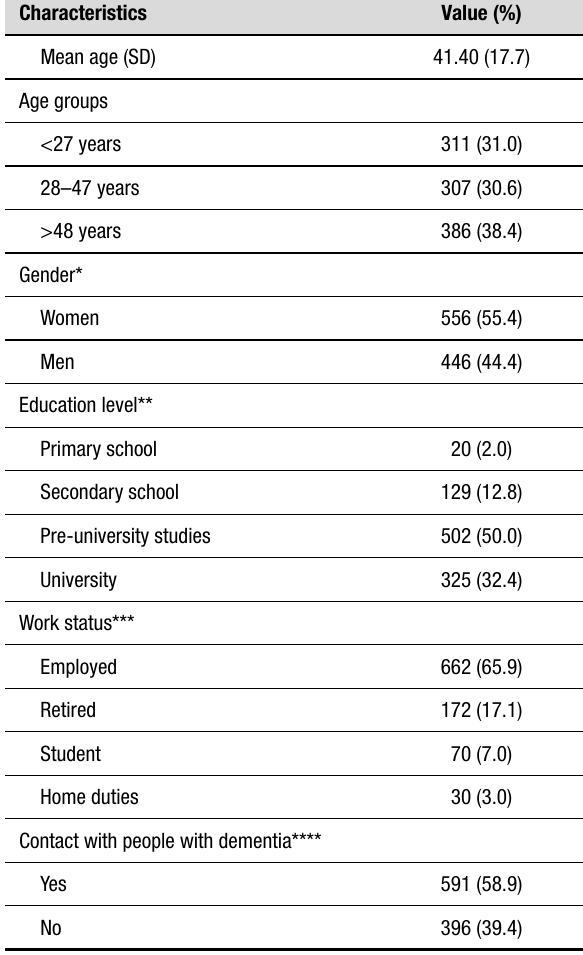
Table 1. Characteristics of survey respondents